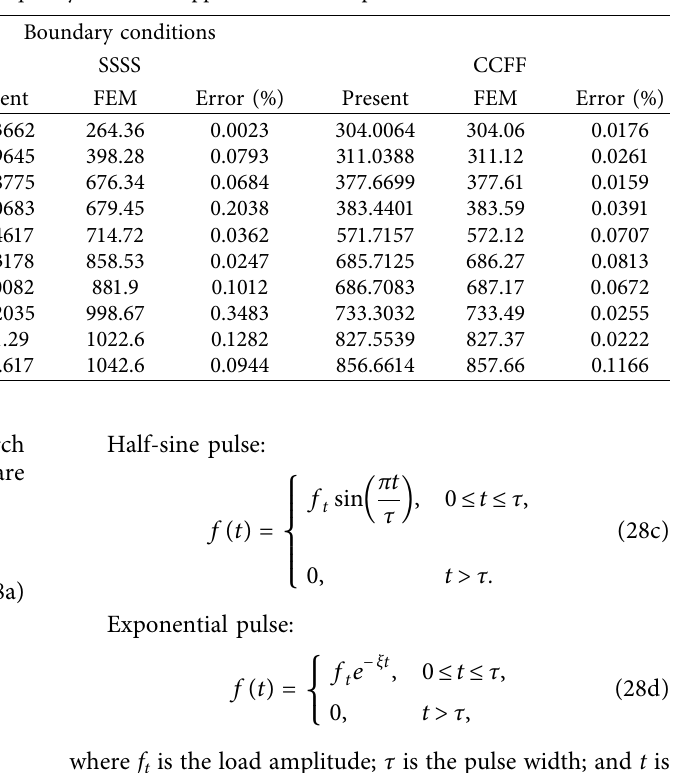
Table 6: Comparison of natural frequency of multi-stepped FG-CNTRC